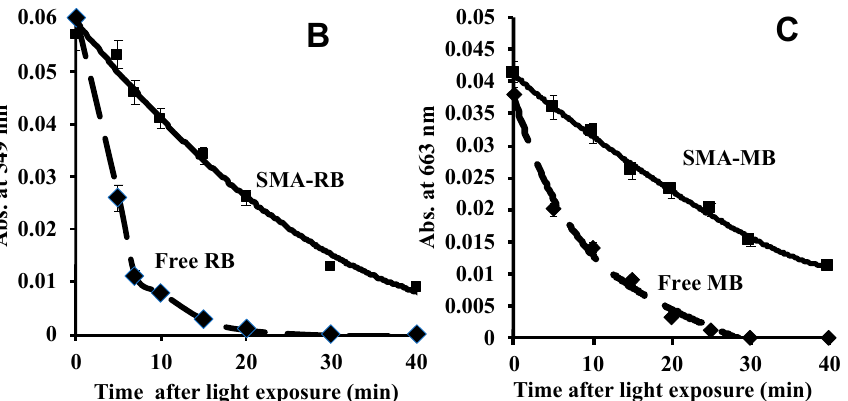
Figure 7. Photodegradation of SMA-PS micelles under irradiation of 12.9 mW using an Xe lamp 300 W (Kodak Ektagraphic III projector). UV absorption spectrum shows photodegradation of SMA-PS micelle (e.g., cSMA-MB) with time of light irradiation ( A ). The peak at 549.5 nm corresponding to RB ( B ) and 664.0 nm corresponding to MB ( C ) diminishes with respect to time of light irradiation. Data are mean ± SD ( n = 3).